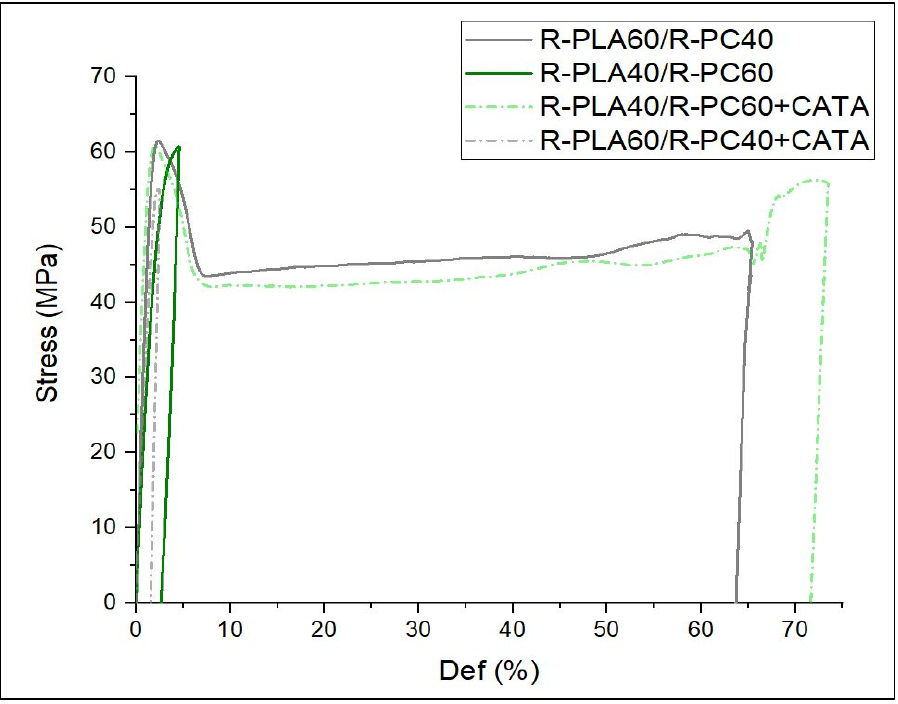
Figure 7 . Stress-strain curves for the R-PLA/R-PC blends with and without CATA . Figure 7. Stress-curves strain curves for the R-PLA/R-PC blends with and without CATA. Table 3. Resum é of the mechanical properties for the blends with the recycled polymers.